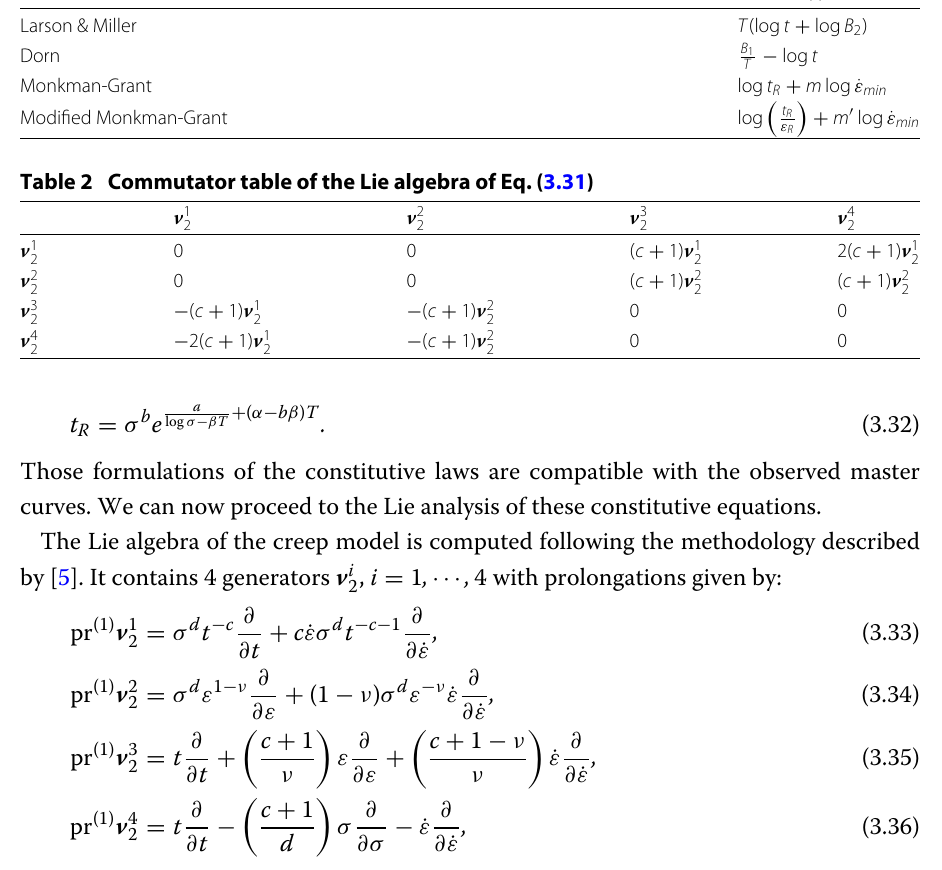
Table 1 Some creep invariants encountered in the literature (see, e.g., Ref. [61]) Authors Invariant(s) Larson & Miller